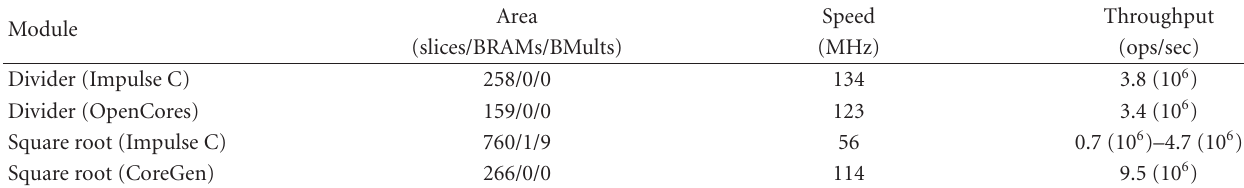
Table 2: Coprocessor module performance benchmarks in an Xilinx xc2vp30.